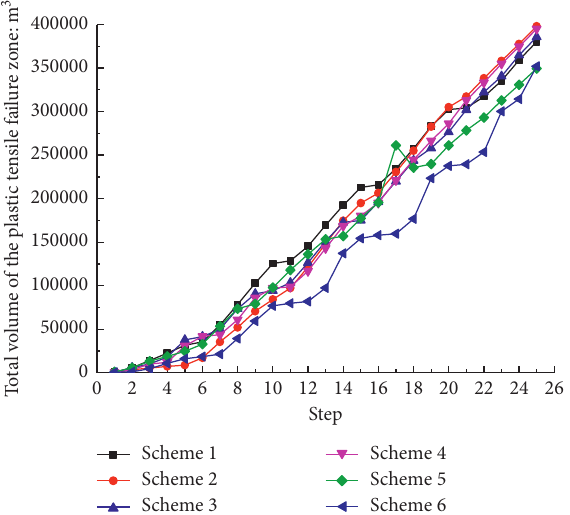
Figure 5: Plastic tensile failure zone of schemes 1–6. Table 2: Calculation results of the six mining sequence